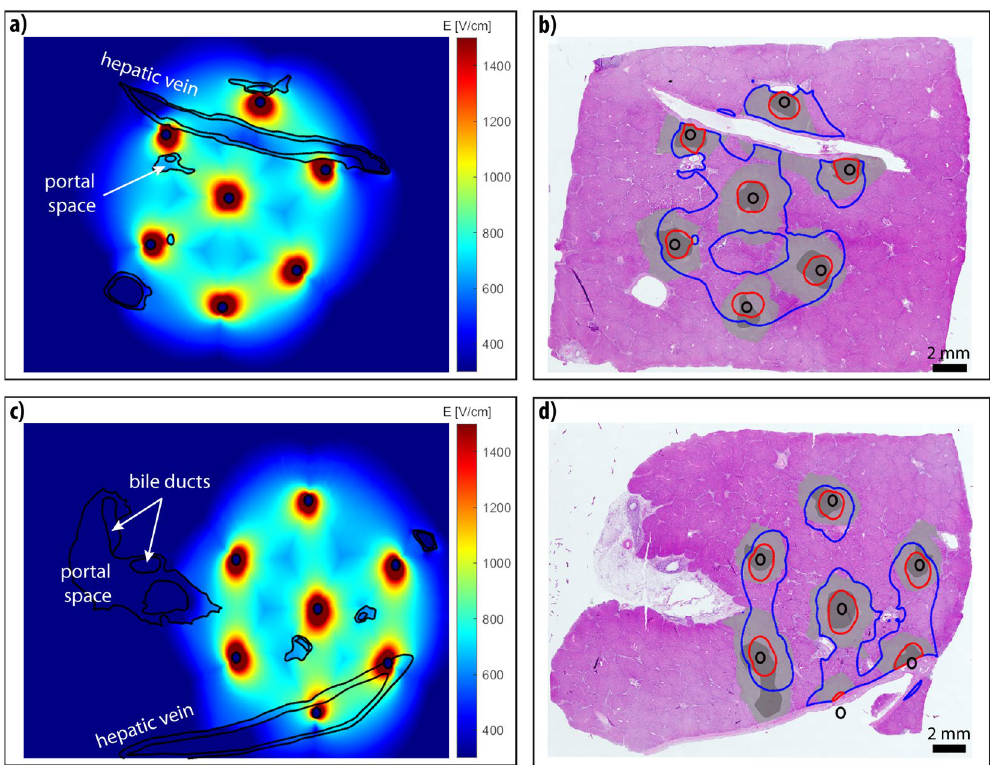
Figure 1. Reconstruction results of cases S1 ( a , b ) and S2 ( c , d ) with hexagonal geometry electrodes. ( a , c ) Computed electric field distribution. Geometric entities are outlined in black. ( b , d ) Segmented Zone A (dark grey) and Zone B (light gray), and computed Zone A (red contour) and Zone B (blue contour) shown as an overlay on the microscopic image of the treated